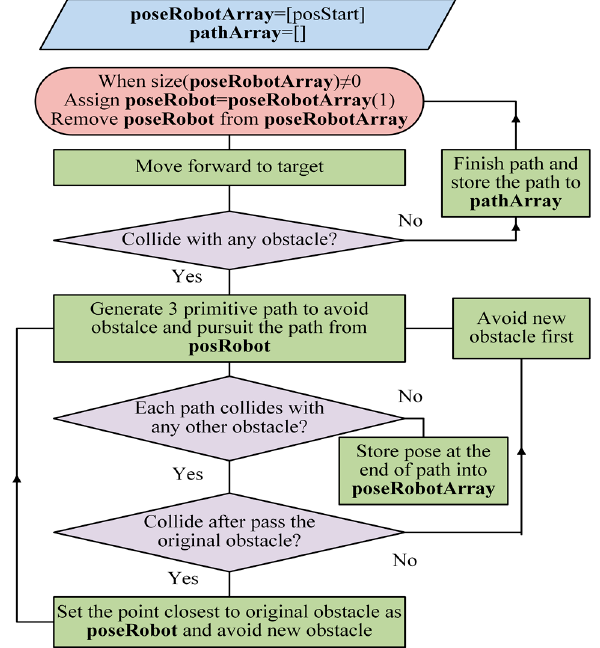
Figure 14. The flowchart of sequential obstacle avoidance by the hydrodynamic path planning with pure pursuit in the multiple obstacles situation.